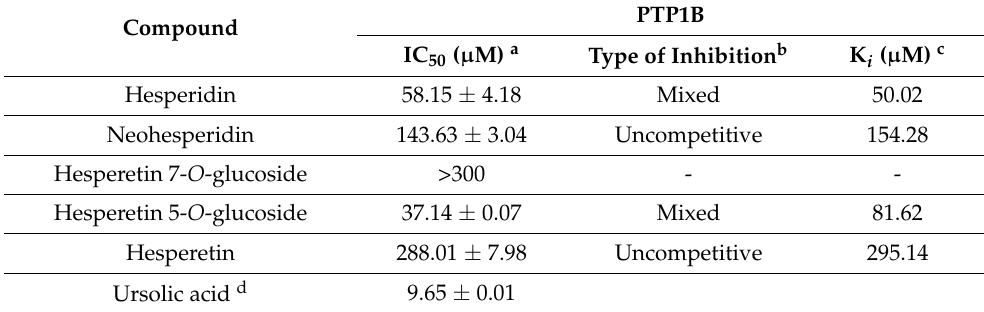
Figure 1. Chemical structures of hesperetin and its glycosylated derivatives. Table 1. Inhibitory activities of hesperetin derivatives on the tyrosine phosphatase 1B (PTP1B) pro- tein.